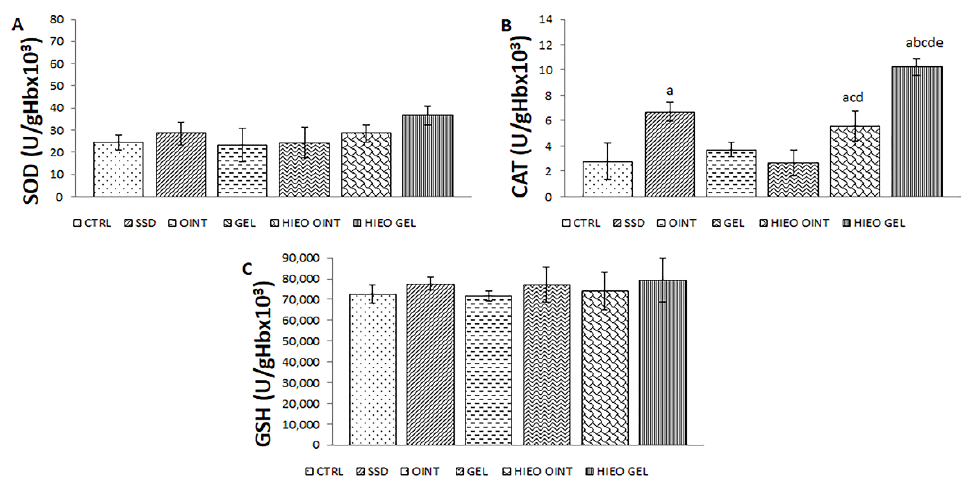
Figure 5. Effects of applied formulations on the parameters of antioxidative defense system: ( A ) SOD; ( B ) CAT; ( C ) GSH. Values are expressed as mean ± standard deviation. Values p < 0.05 were considered to be statistically significant. a Statistical significance in relation to CTRL group; b Statistical significance in relation to SSD group; c Statistical significance in relation to OINT group; d Statistical significance in relation to GEL group; e Statistical significance in relation to HIEO OINT